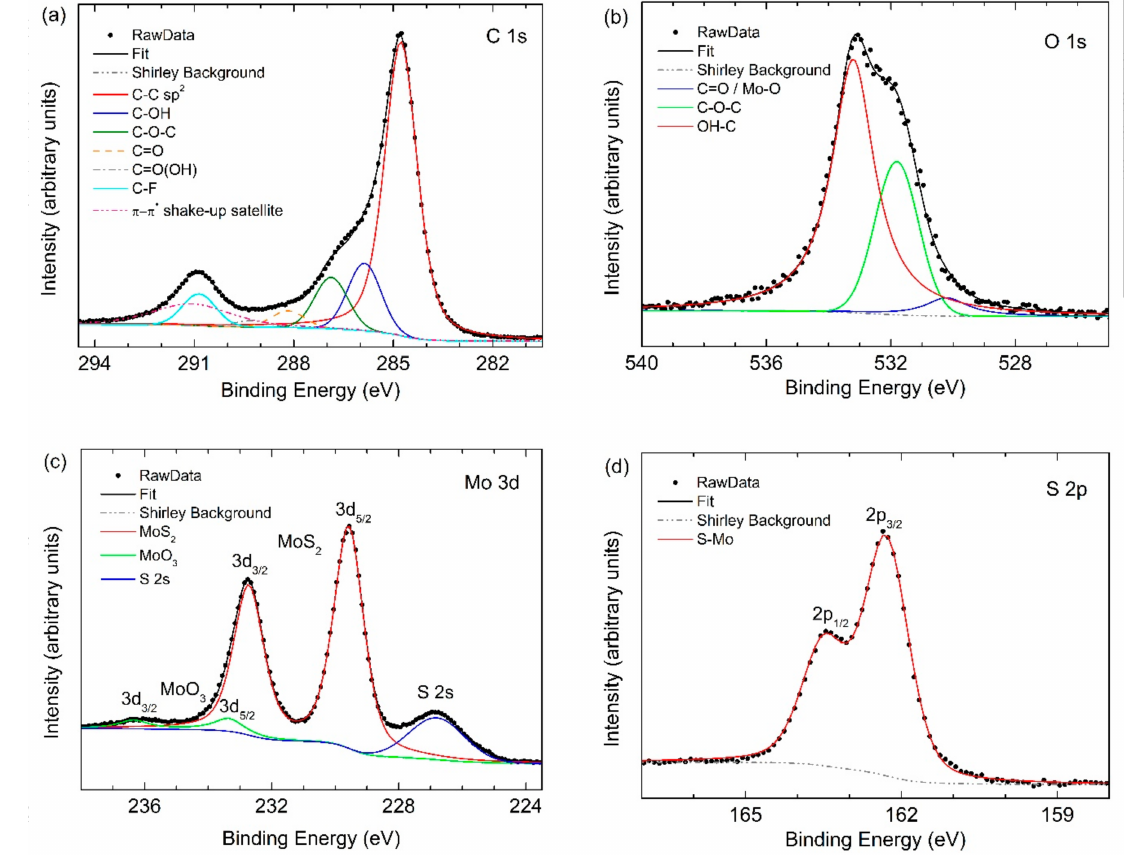
Figure 2. XPS Characterization of MoS 2 nanoflowers. Component peak-fitting of XPS spectra is shown for ( a ) C 1s region where C–C, C–OH, C–O–C, C = O, C = O(OH) and C–F are visible; ( b ) O 1s; ( c ) Mo 3d; ( d ) S 2p. Black solid lines represent the overall fit of experimental data (scattered points). The various peaks under the overall fitting curves represent the various components assumed to